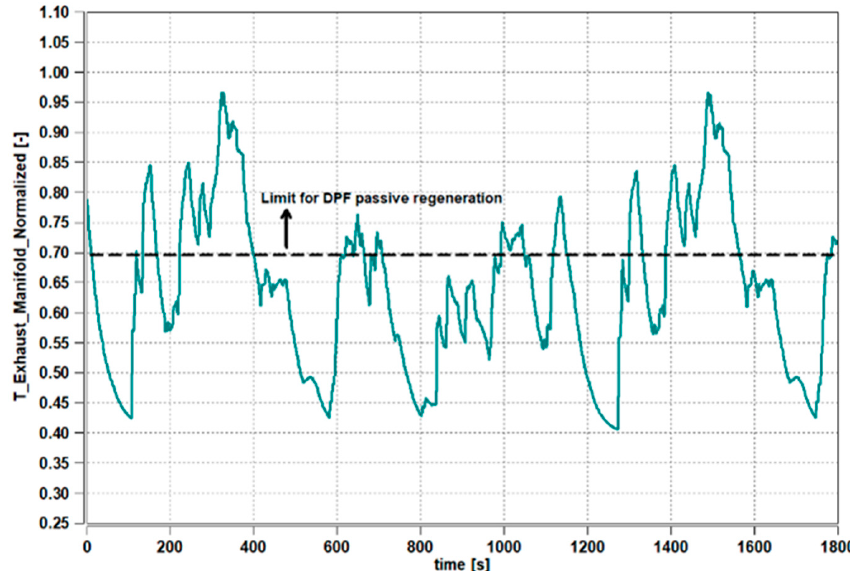
Figure 26. Top: engine speed (normalized with respect to the maximum value reached in the test) of vehicle duty cycle; Bottom: injected quantity of vehicle duty cycle (normalized with respect to the maximum value reached in the test).